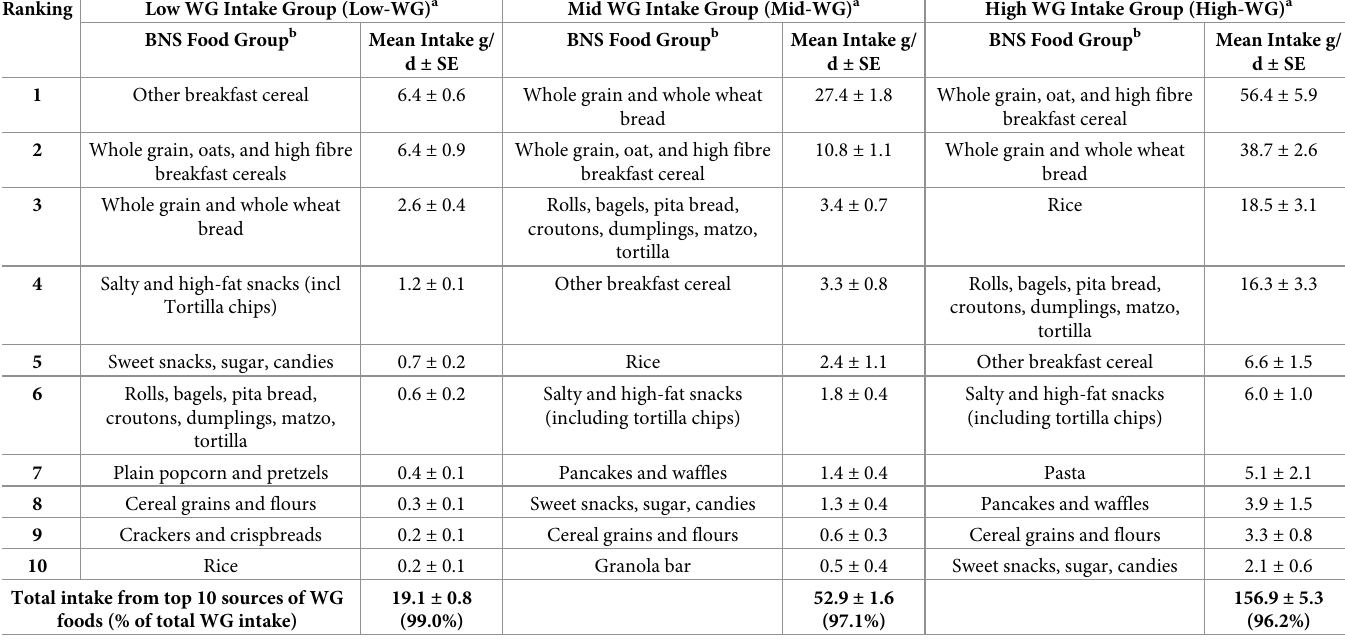
Table 4. Top ten food sources of whole grain for Canadian children stratified by whole grain intake.